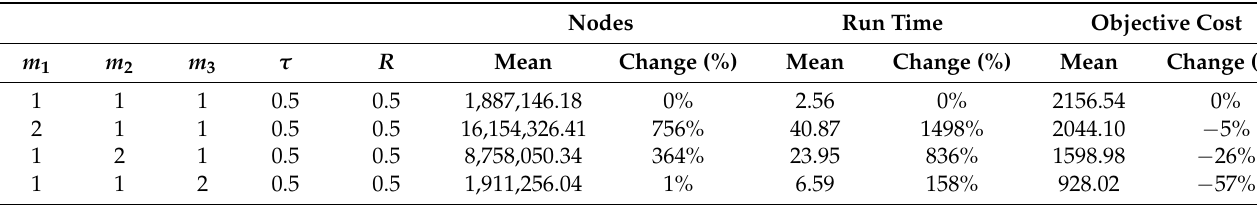
Figure 6. The influences of Table 9. The sensitivity test of BB for n =